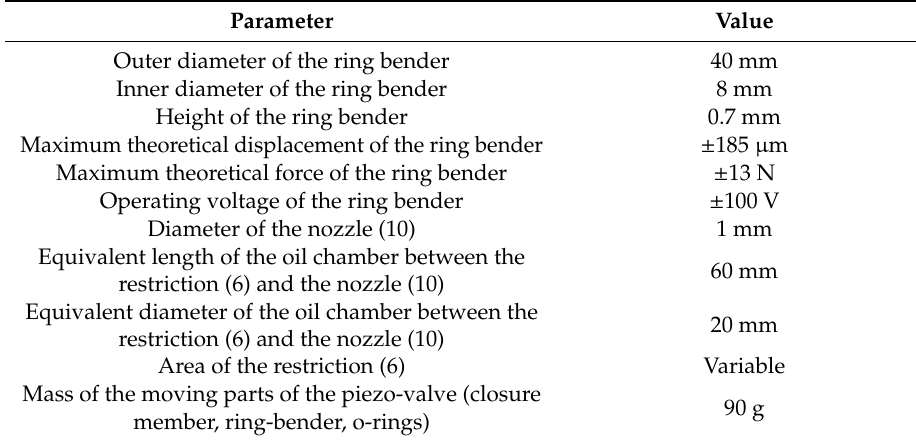
Table 1. Main geometrical parameters of the test rig ( + denotes opening direction; − denotes closing direction) .